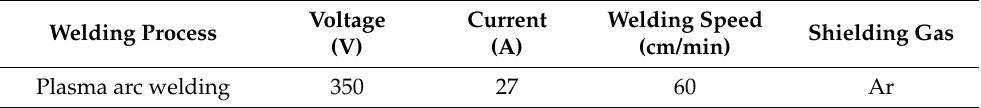
Table 3. Welding parameters of weld